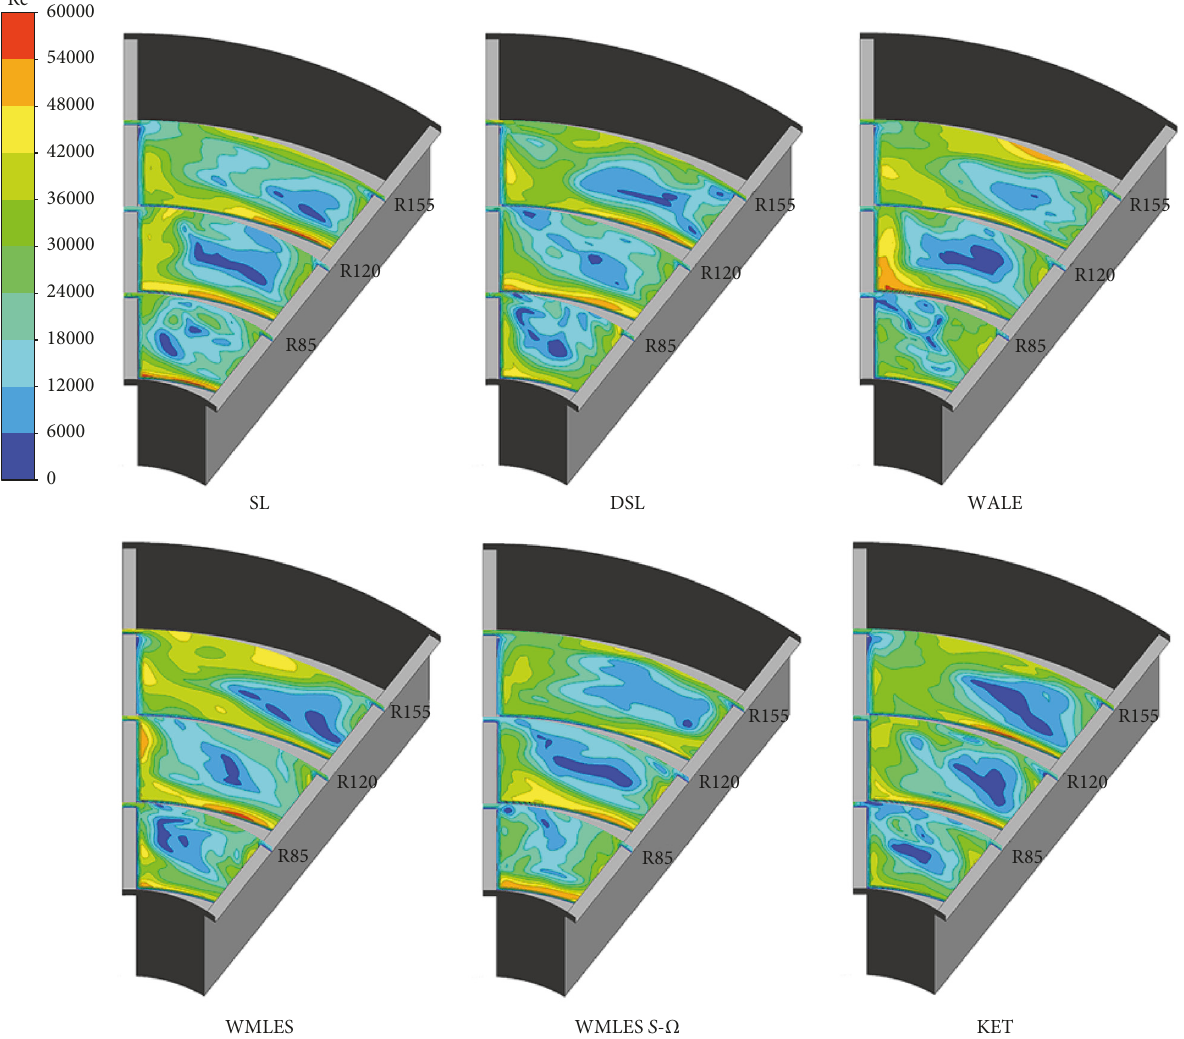
Figure 2: Re distribution on radial